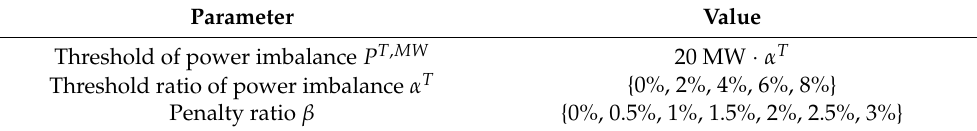
Table 5. Parameters in each scenario.